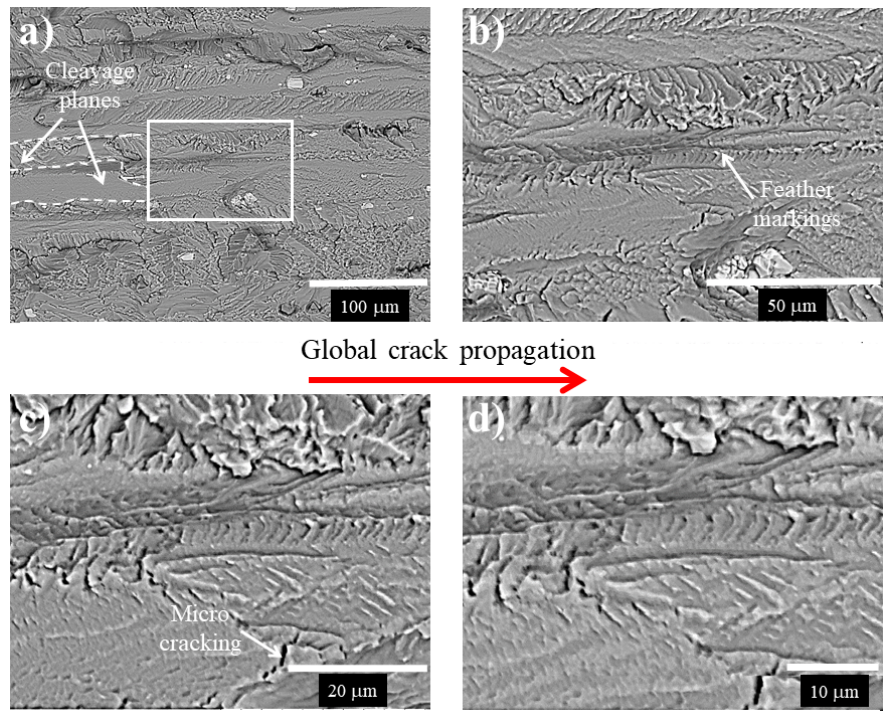
Figure 14. Fracture surface of the 7075-T651 aluminum alloy, after the LCD performed at 12.5 kN, ( a ) image taken at lower magnification showing Fe-rich particles, ( b – d ) details of the rectangle marked in ( a ) at higher magnifications.